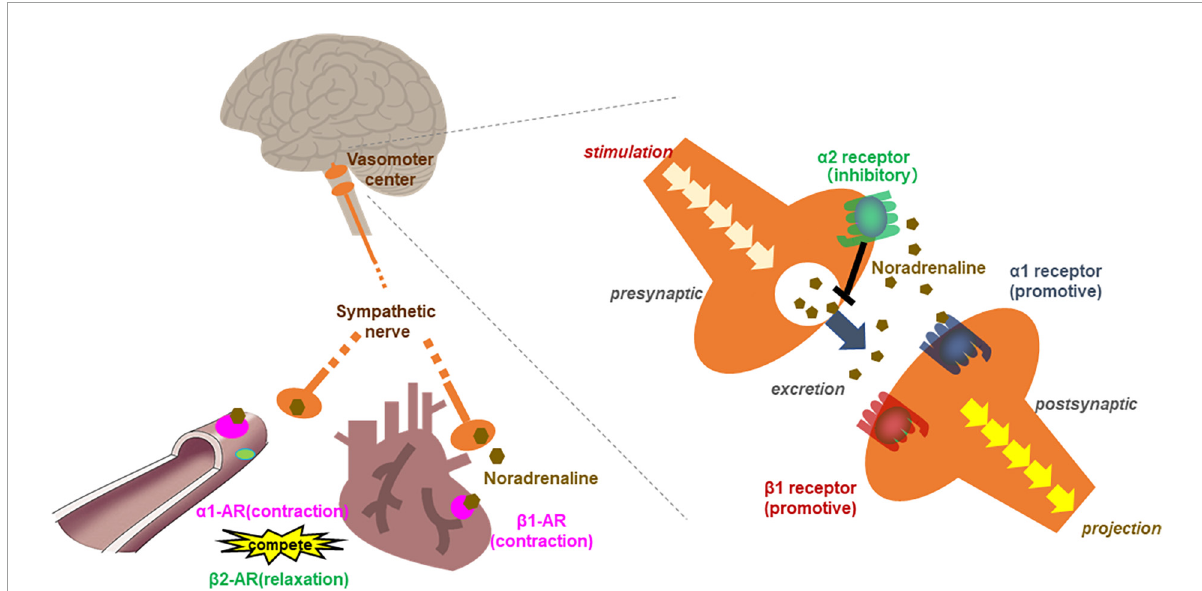
FIGURE3 Scheme of the relationship between adrenergic receptors in the circulation system. β 1 adrenergic receptors contracts the myocardium and increased cardiac output and heart rate. α 1 adrenergic receptor in vascular smooth muscle contracts blood vessels, leading to elevated blood pressure. While β 2 receptor relaxes vascular smooth muscle as a competitive effect against α 1 adrenergic receptors. In the vasomotor center, presynaptic neurons release noradrenaline (NA) into the synaptic cleft upon stimulation. Noradrenaline binds the activating receptors of the postsynaptic neuron. NA also binds inhibitory autoreceptors of the presynaptic neurons, consequently, inhibited NA release from postsynaptic